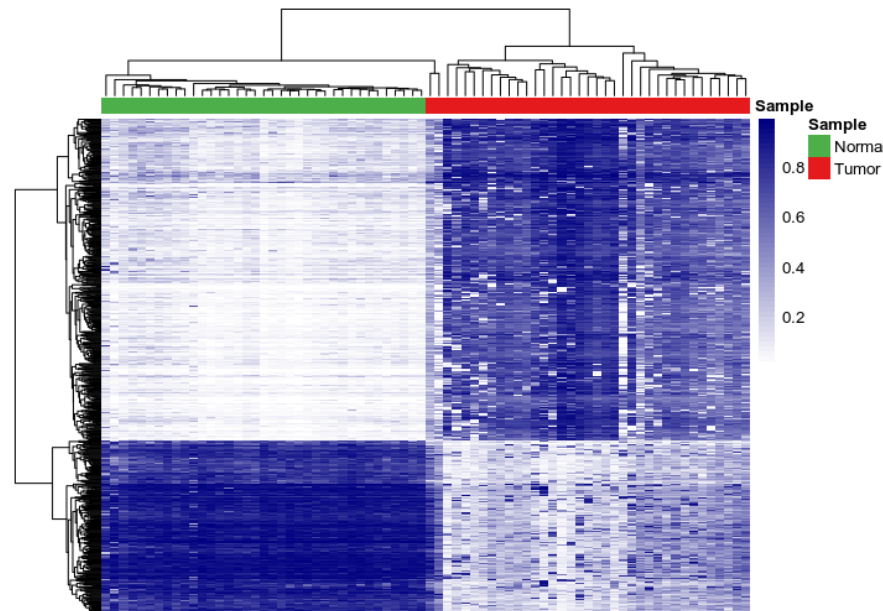
Figure 3. Patterns of DNA methylation for tumor and normal paired samples for the top 779 most highly significantly differentially methylated CpG sites between tumor and normal samples associ- ated with CRC. Blue color indicates high beta value and white color indicates low beta